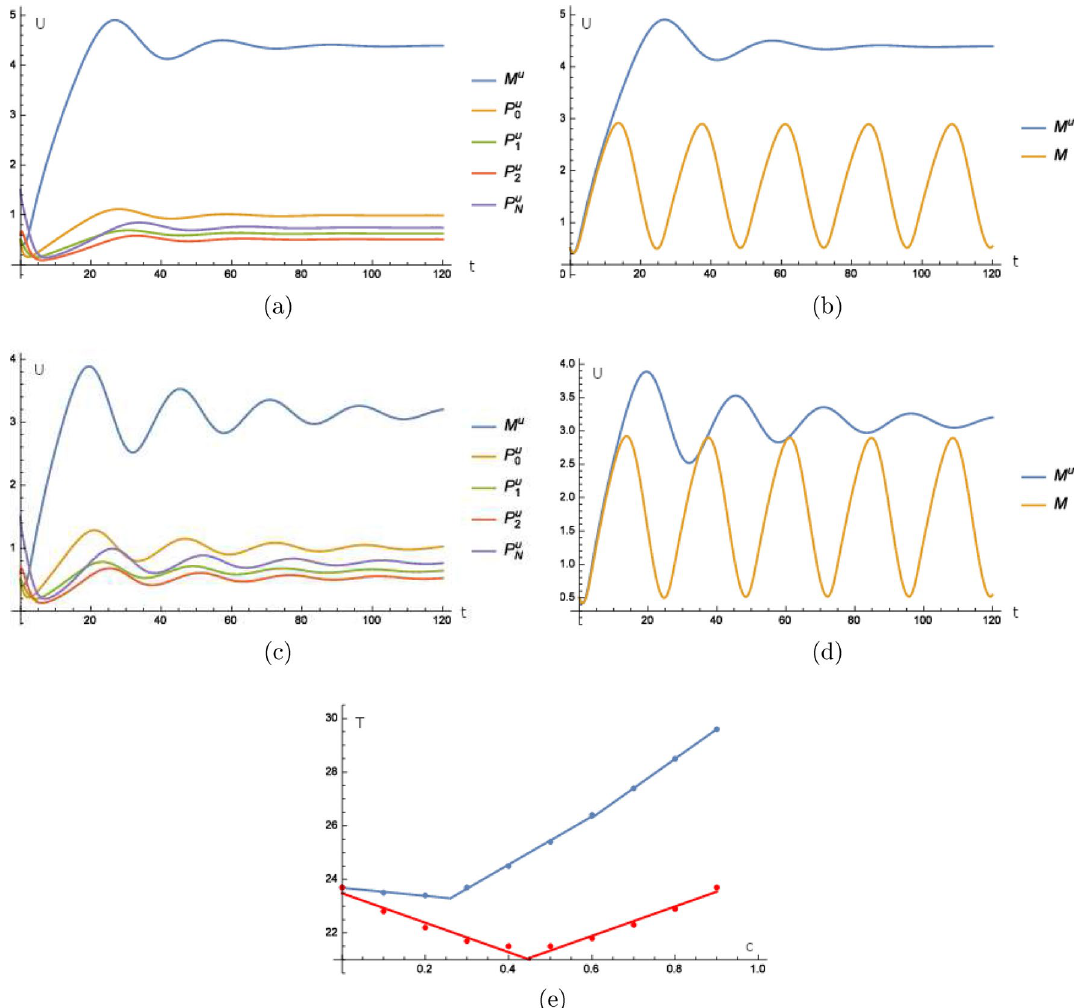
Figure 4. Aschoff’s rule: a strong permanent external stimulus causes arrhythmic behavior as the oscillations are dampened off. ( a ) Time curves where the superscript u indicates that these time curves stem from the extended model consisting of (1) to (5) where (2) is replaced by (8) for (10) with α = 1 and c = 1 . ( b ) Time curve of M calculated from the model (1) to (5) and of M u calculated from (1) to (5) where (2) is replaced by (8) for (10) with α = 1 and c = 1 . In ( c ) and ( d ) a weak permanent external stimulus causes dampening of the amplitude of the oscillations, however they are still measurable. The experiment is as in ( a ) and ( b ) with c = 0.5 . Units and dimensions for ( a )–( d ): abscissa t : time in hours, ordinate U : amount of substance ( M , M u mRNA, P u i , { 0, 1, 2, N } , protein, u intensity of illumination). In ( e ) we have on the abscissa the illuminance c and on the ordinate we have the period length T in hours. The periods of the endogenous clocks of the fly and the mammalian model under a constant external stimulus. The blue graph is from the fly model and the red one is from the mammalian model. The data points for the fly model are ( 0, 23.7 ) , ( 0.1, 23.5 ) , ( 0.2, 23.4 ) , ( 0.3, 23.7 ) , ( 0.4, 24.5 ) , ( 0.5, 25.4 ) , ( 0.6, 26.4 ) , ( 0.7, 27.4 ) , ( 0.8, 28.5 ) , ( 0.9, 29.6 ) . The data points for the mammalian model are ( 0, 23.7 ) , ( 0.1, 22.8 ) , ( 0.2, 22.2 ) , ( 0.3, 21.7 ) , ( 0.4, 21.5 ) , ( 0.5, 21.5 ) , ( 0.6, 21.8 ) , ( 0.7, 22.3 ) , ( 0.8, 22.9 ) , ( 0.9, 23.7 )